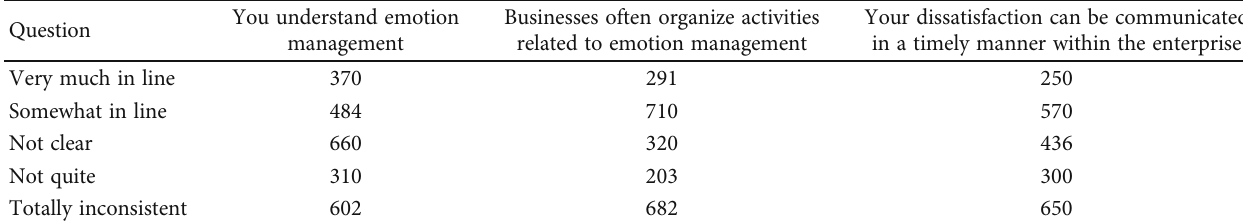
Table 5: Question setting and evaluation of publicity and counseling.